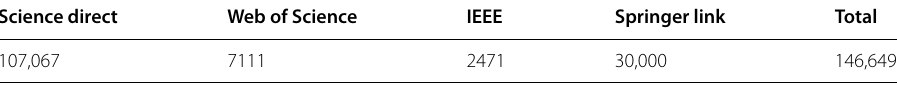
Table 4 Inclusion and elimination criteria stage Science